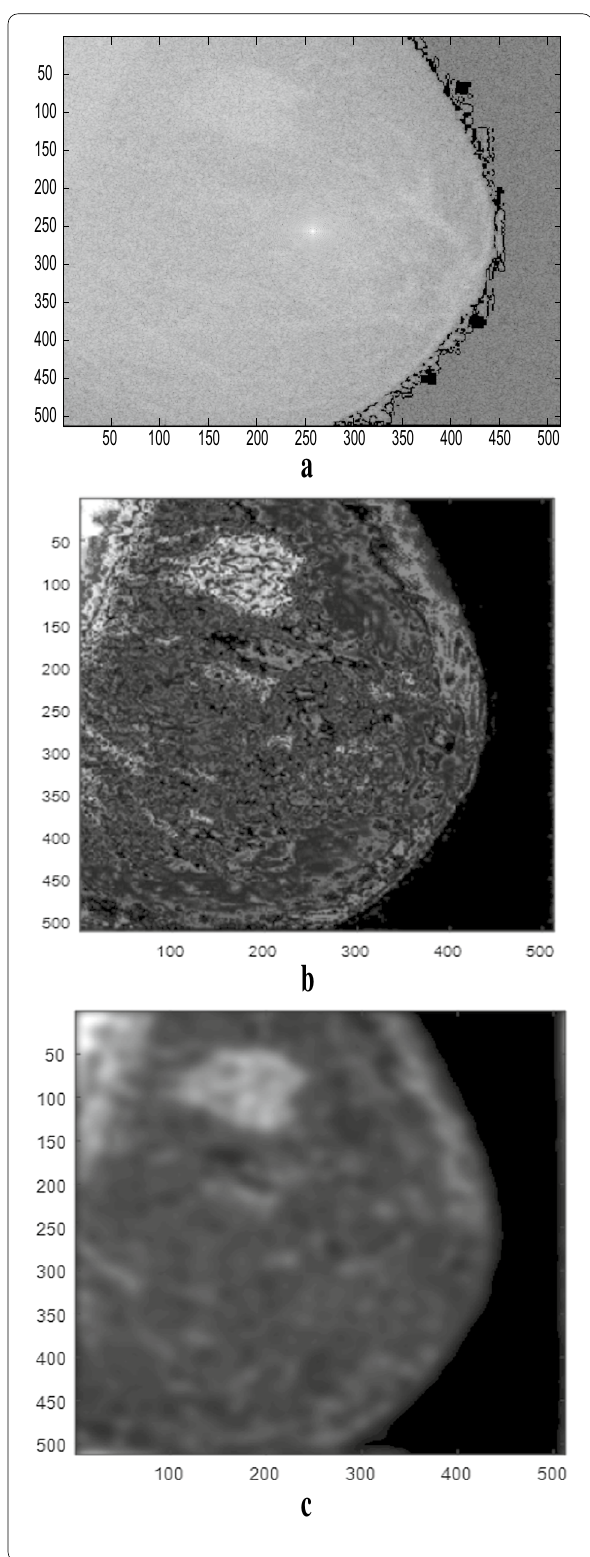
Fig. 8 a The detected intensity originated from the multiplication of the modulated diffuser with the object transparency affected by the PSF corresponding to both objectives. b The detected intensity obtained in absence of the diffuser using mechanical scanning of the object synchronized with the electronic scanning in the detection plane. The microscope used is called confocal laser scanning microscope (CLSM). The aperture radius 128 pixels. c The detected = intensity obtained in absence of the diffuser. The microscope used is called confocal laser scanning microscope (CLSM). The aperture radius 16 =